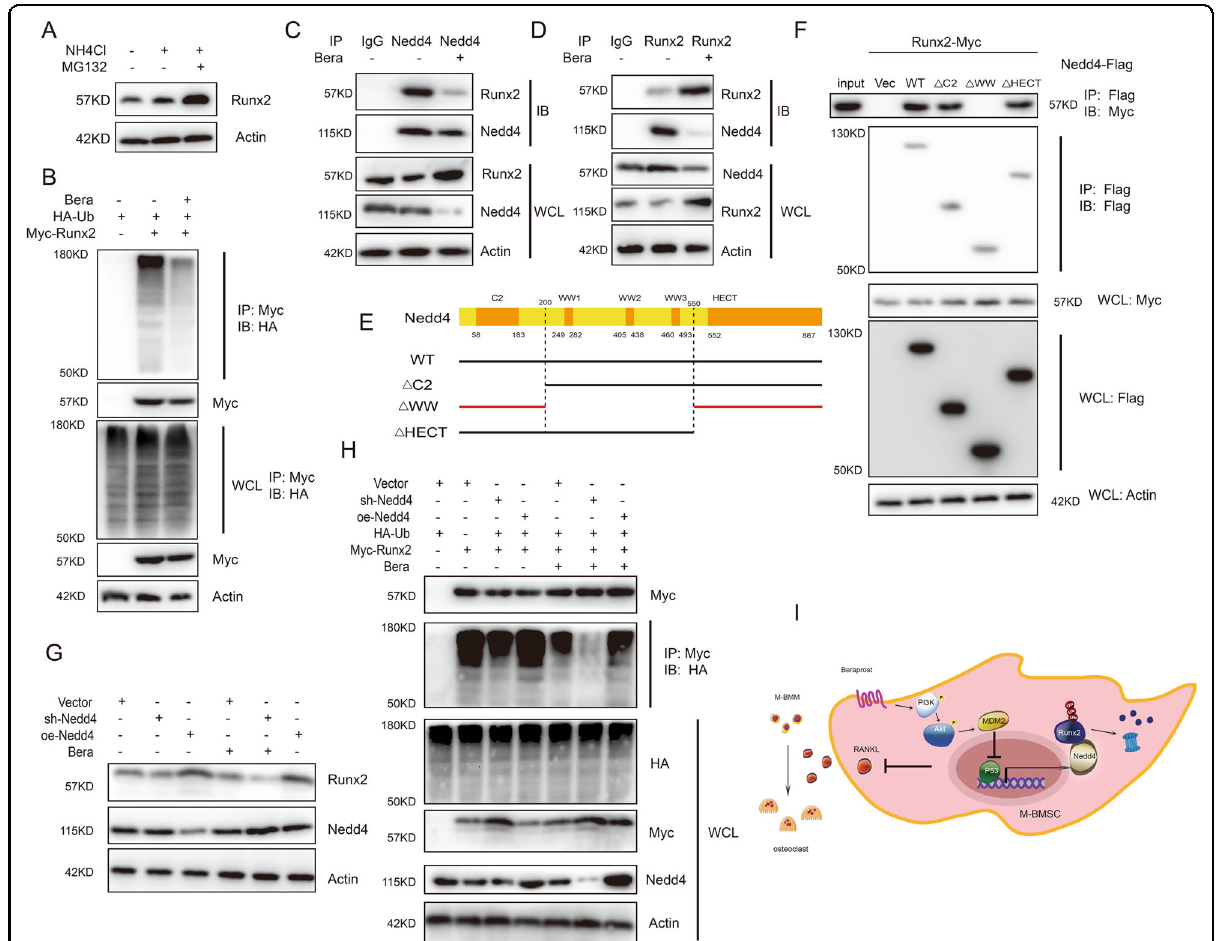
transfection, the cells were treated with PBS or beraprost (10 µM) for 12 h, and then lysed using RIPA buffer. Lysates were immunoprecipitated with mouse anti-myc antibody. Western blotting was performed to analyze the levels of ubiquitination. C , D Interaction between endogenous Runx2 and Nedd4 following beraprost treatment. M-BMSCs treated with PBS or beraprost (10 µM) for 12 h were lysed with RIPA buffer. Whole-cell lysates (WCL) were used for IP with IgG, anti-Nedd4 antibody or anti-Runx2 antibody, followed by immunoblotting (IB) with the indicated antibodies. E Schematic illustration of wild-type and deletion mutants of Nedd4. F The WW domain of Nedd4 is necessary for interaction with Runx2. Myc-Runx2 was co- transfected with various fl ag-Nedd4 deletion mutants in M-BMSCs. WCLs were used for immunoprecipitation with anti- fl ag antibody, and IB with anti- fl ag or anti-myc antibodies. WCL was IB as a control to show the protein expression. G M-BMSCs transfected with lentiviral vector, lentiviral shRNA against Nedd4 or lentivirus encoding Nedd4 were treated with PBS or beraprost (10 µM) for 12 h. Protein expression levels of Runx2 and Nedd4 were measured by western blotting. H Knockdown of Nedd4 decreased the ubiquitination of Runx2 in vitro. M-BMSCs were transfected with the indicated plasmids. Two days after transfection, the cells were treated with PBS or beraprost (10 µM) for 12 h, and the cells were lysed with RIPA buffer. Lysates were immunoprecipitated with mouse anti-myc antibody. Western blotting was performed to analyze the levels of ubiquitination.